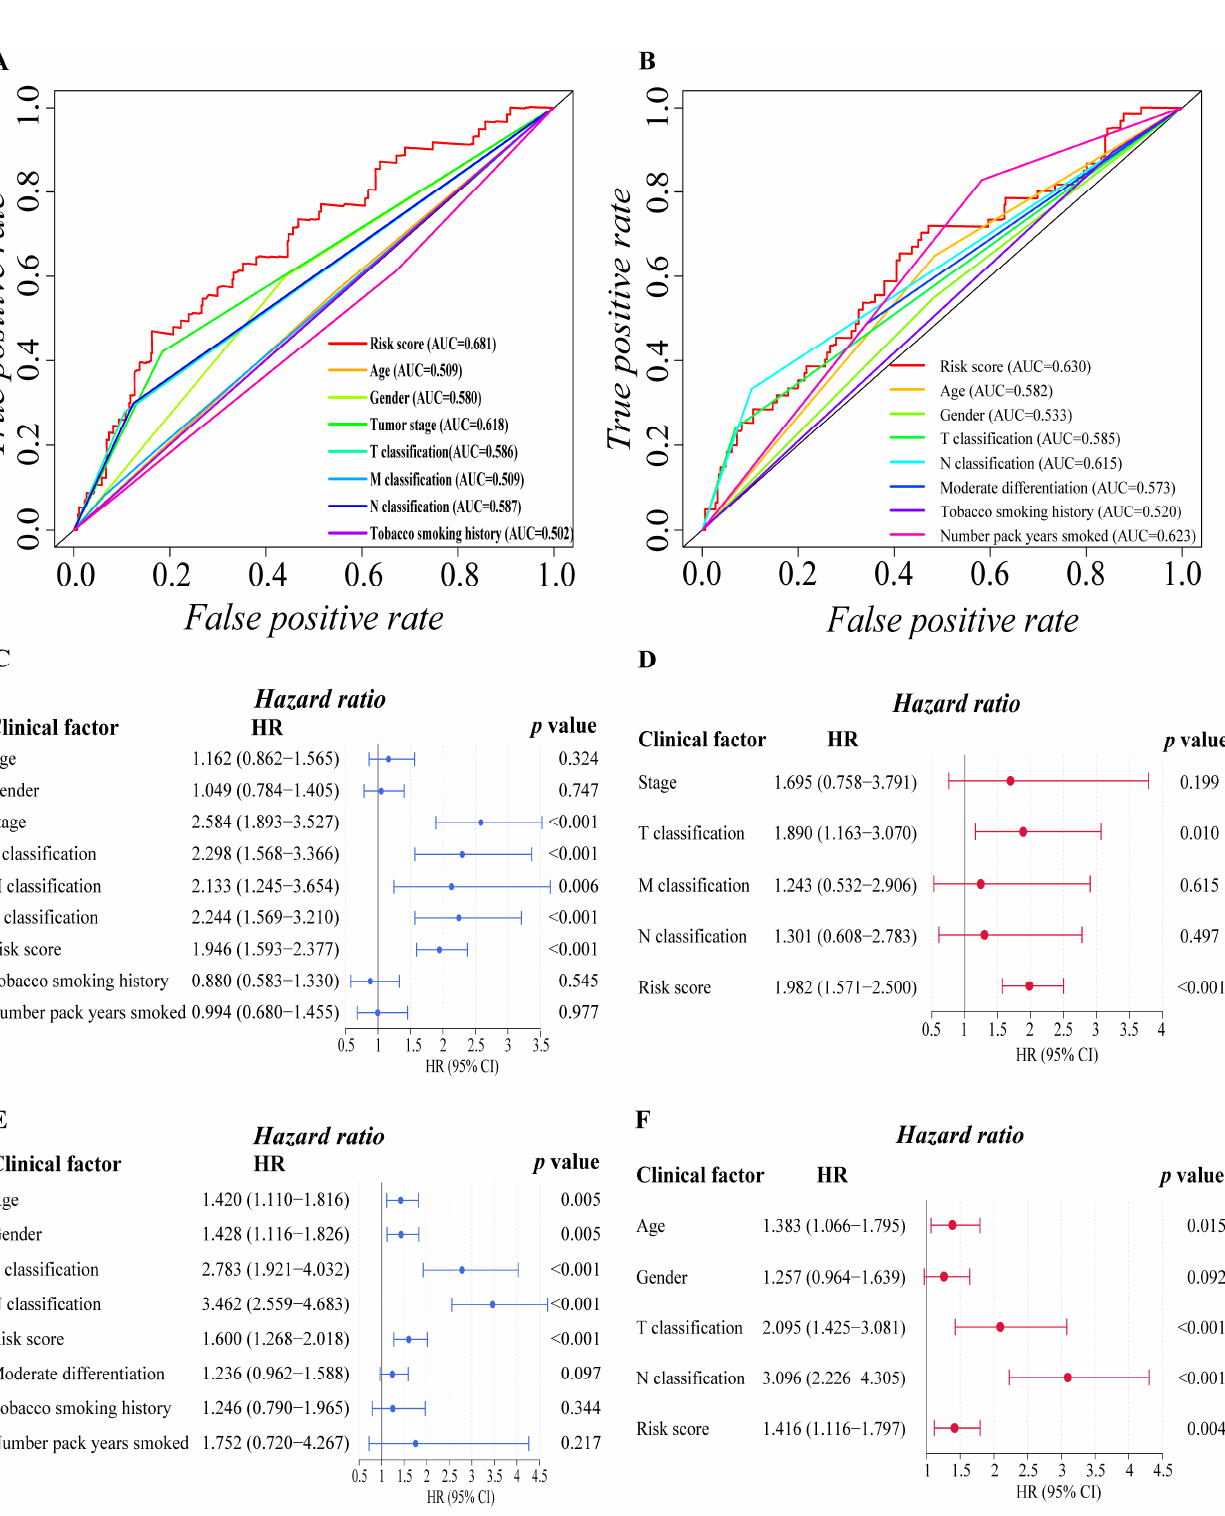
Figure 3. Evaluation of prognostic predictive efficacy of traditional clinical characteristics and six-gene signature. ( A,B ) ROC curve analysis shows the prognostic prediction efficiency of the traditional clinical characteristics (( A ): training cohort; ( B ): validation cohort). ( C – F ) Forest plot of univariate Cox regression analysis (( C ): training cohort; ( E ): validation cohort) and multivariate Cox regression analysis (( D ): training cohort; ( F ): validation cohort) of the six-gene prognostic signature and other clinical characteristics.